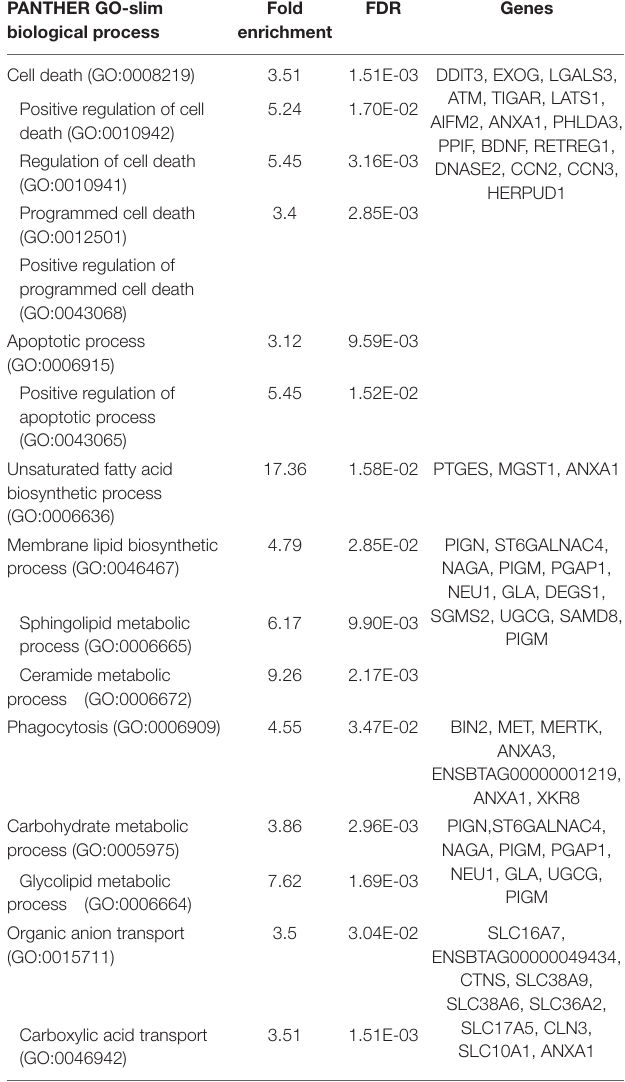
TABLE 2 | Enrichment of genes contributing to the first dimension of between-class PCA (negatively correlated) and associated with ICM from the “SC” IVP treatment